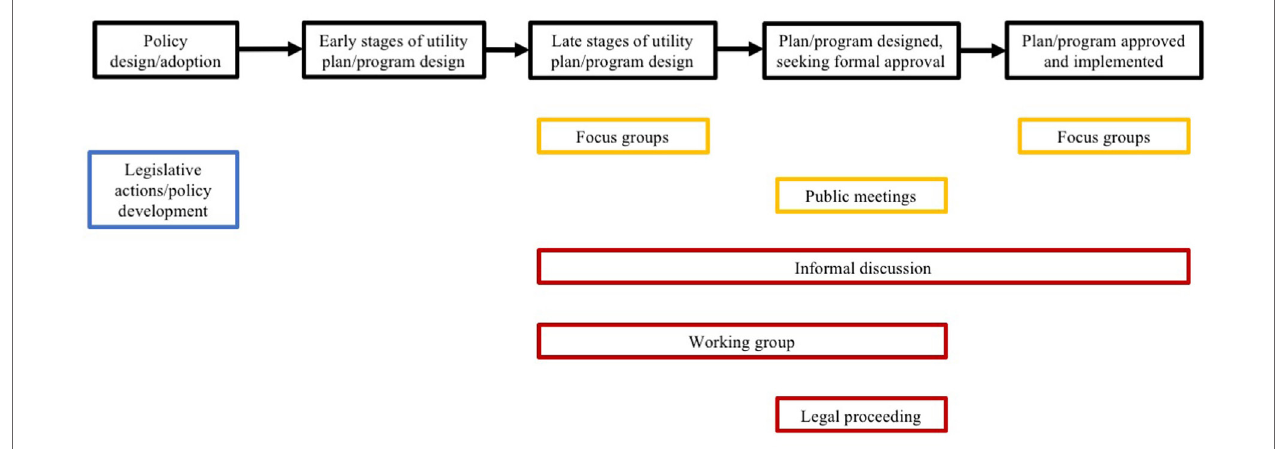
FigUre 1 | Stages in the decision-making process during which stakeholders participate through a variety of